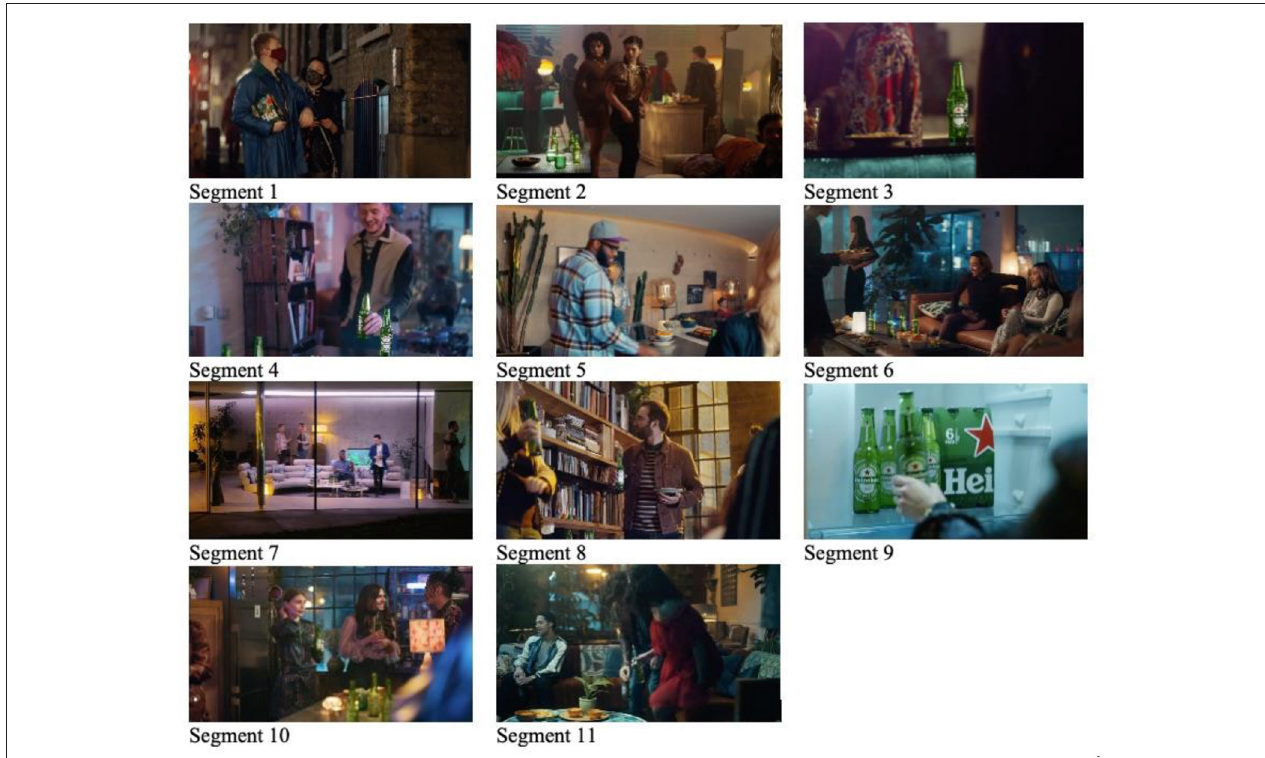
FIGURE 2 | Screenshots of the 11 discourse segments in the Heineken video “Home Gatherings”.